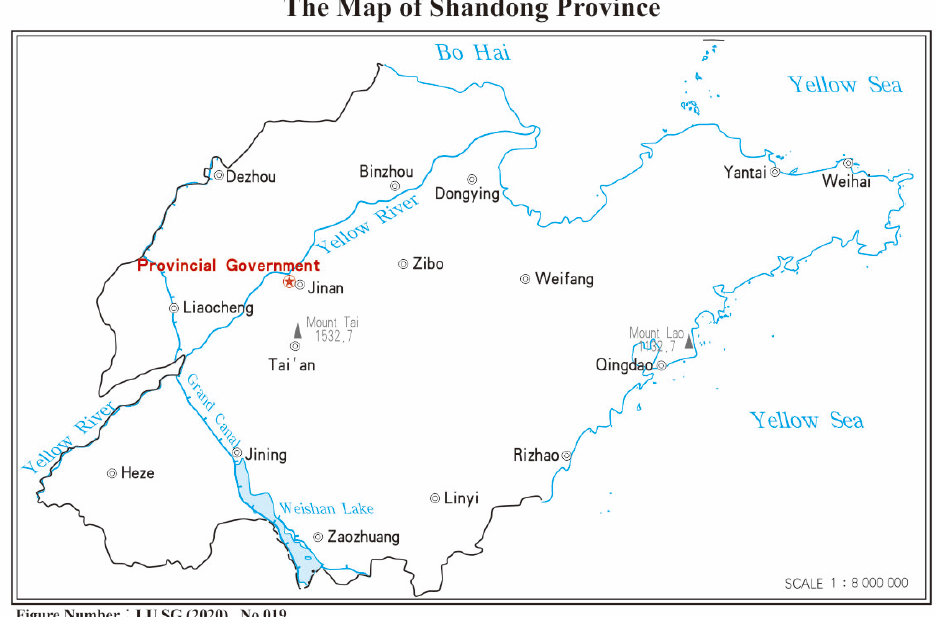
Figure 2. Location of Qingdao in Shandong Province (Department of Natural Resources of Shandong Province, Map Approval Number: LU SG(2020) No. 019).